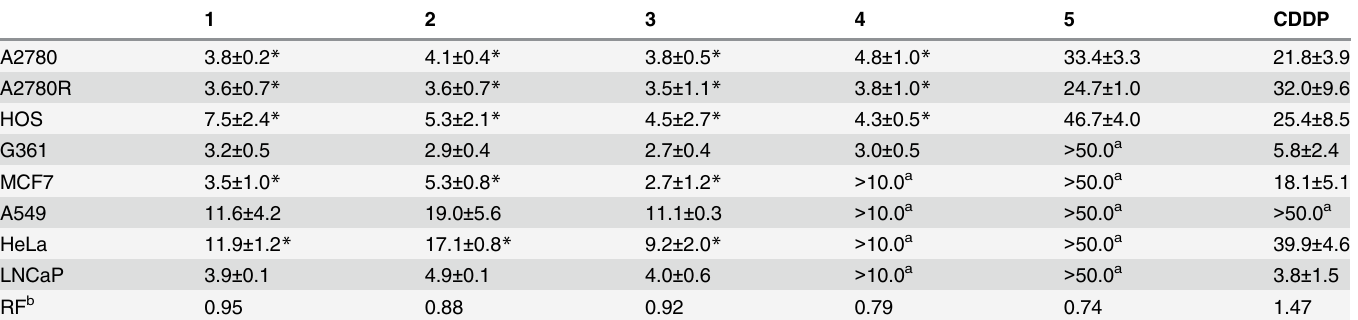
Table 1. The results of in vitro cytotoxicity of 1 – 5 and cisplatin (CDDP) against eight human cancer cell lines. Cells were treated with tested com- pounds for 24 h, measurements were performed in triplicate, and cytotoxicity experiment was repeated in three different cell passages. Data are expressed as IC 50 ± SD ( μ M).